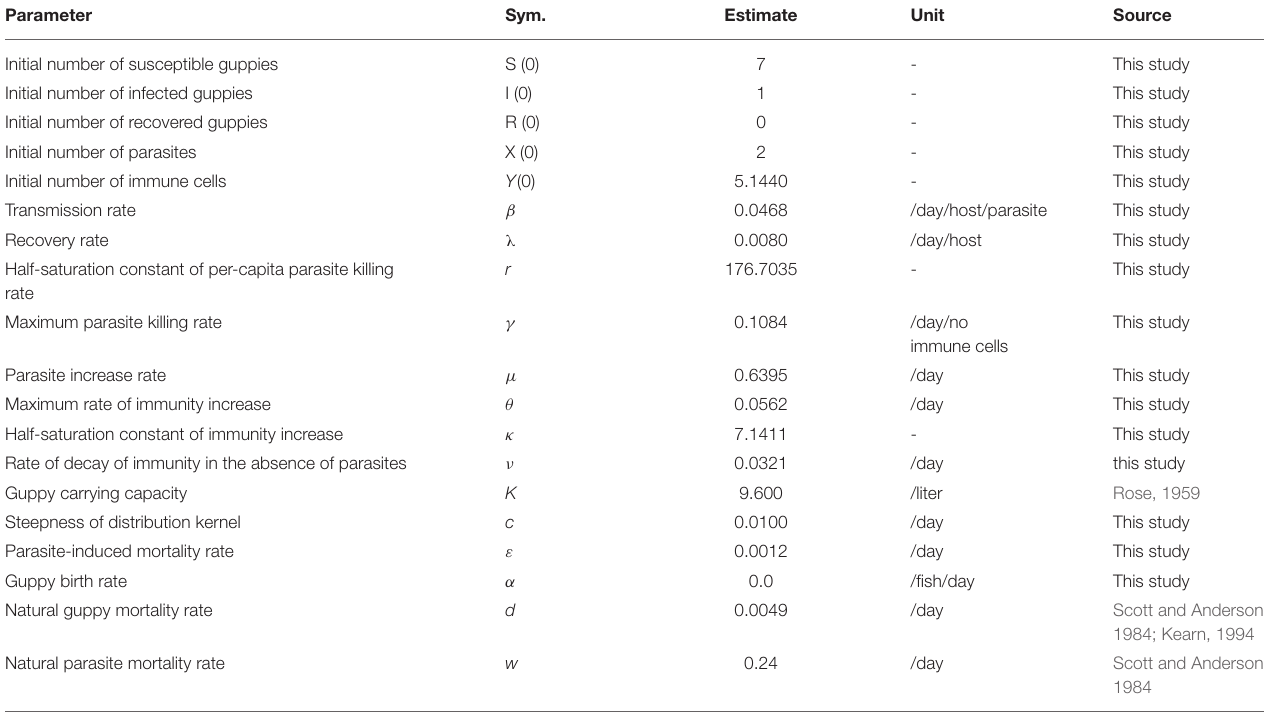
TABLE 1 | Estimated parameter values used to train and test the model and initial values from experiments. Parameter